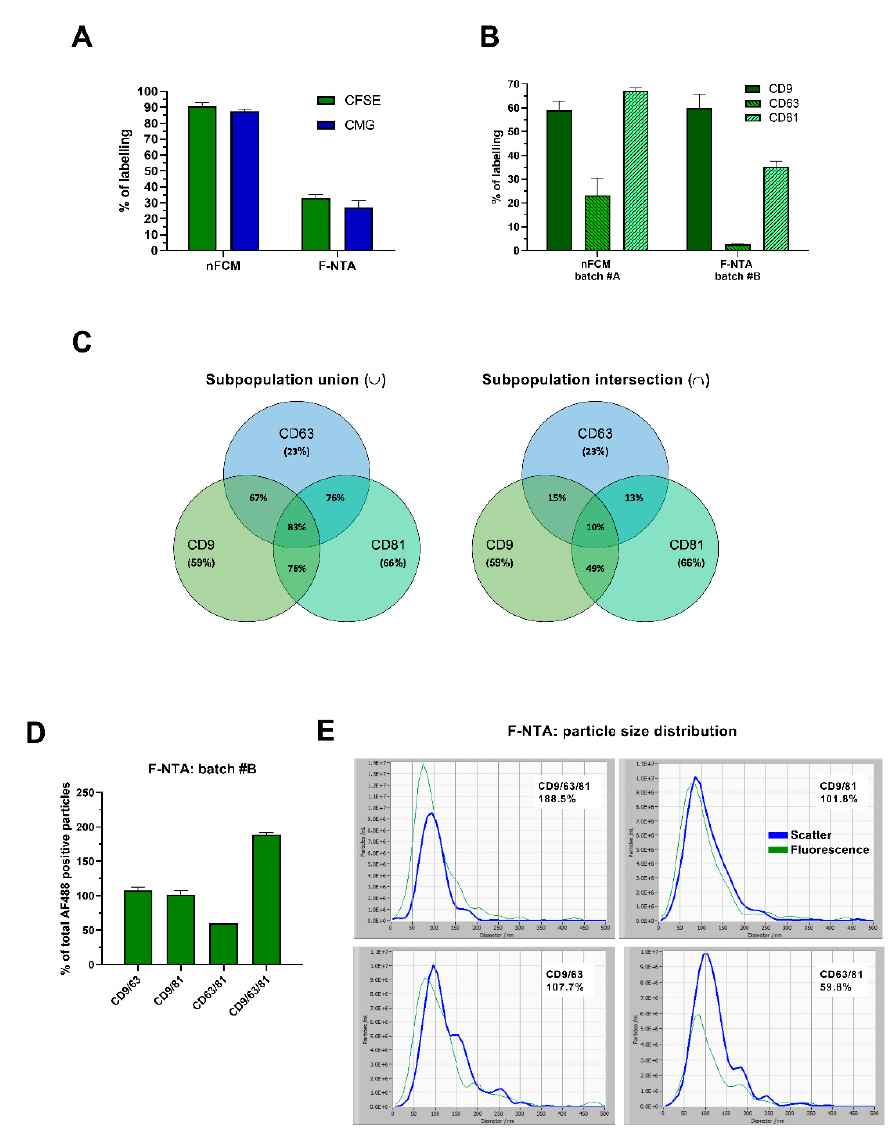
Figure 5. Characterization and quantification of sEVs directly from non-purified cell-conditioned media. HT29 CCM particles were stained and analyzed following the optimized protocols for sEV labeling with CMG, CFSE or fluorescently labeled anti-tetraspanin antibodies. ( A ) Staining efficiencies of CMG-, CFSE-, and ( B ) single antibody-labeling were assessed on both platforms. ( C ) Co-expressing markers were also evaluated on HT29 CCM by applying a mix of 2 and 3 anti-tetraspanin, PE-conjugated antibodies for nFCM measurements. The Venn diagram on the left depicts subpopulations that carried 1, 2, or 3 tetraspanins, while the one on the right represents sEV subpopulations which expressed 2 or 3 markers simultaneously. ( D ) HT29 CCM staining employing mixes of 2 and 3 AF488-labelled anti-tetraspanin antibodies was carried out for F-NTA, and staining efficiencies, as well as the ( E ) PSDs in scatter and fluorescence modes were assessed. Data represents triplicate experimental points ( n = 3; mean ± SEM), except for ( C ) which was performed in two independent experiments ( n = 2; mean ± SEM). F-NTA PSD histograms of CCM samples after CFSE-, CMG- and single antibody-labelling, are provided in Supplementary Figure